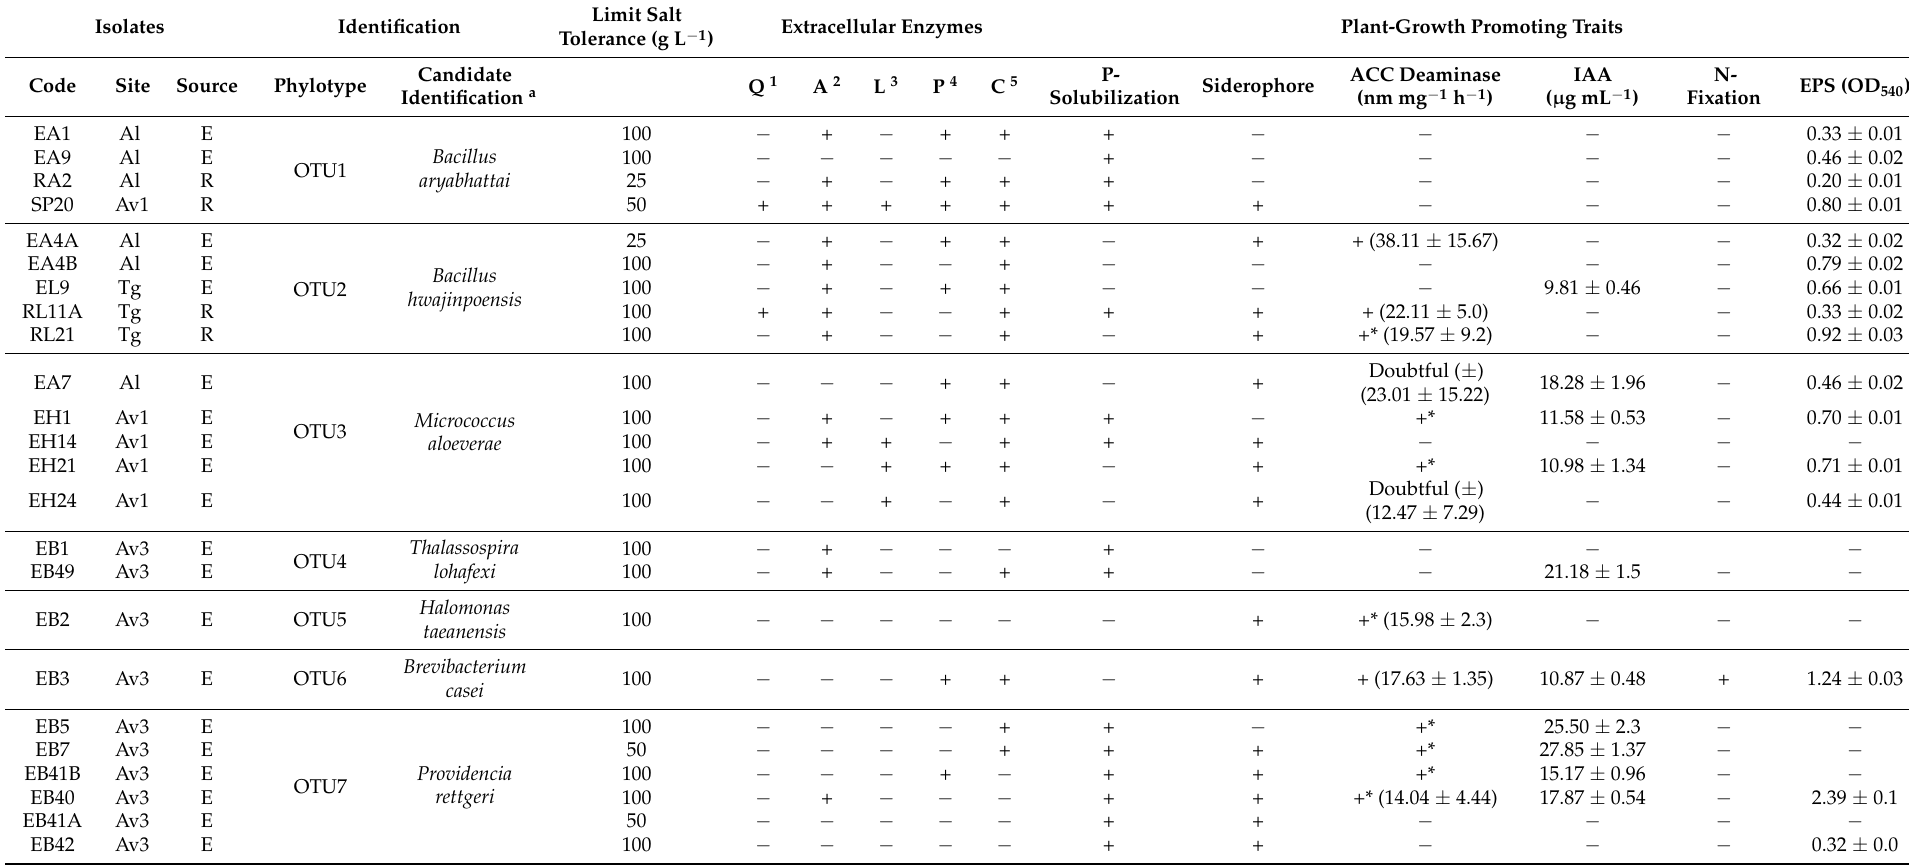
Table A1. Summary of the isolation site, source and corresponding phylotypes (OTUs) of the bacteria isolates and their results for salt tolerance and plant growth promotion activities tested in this